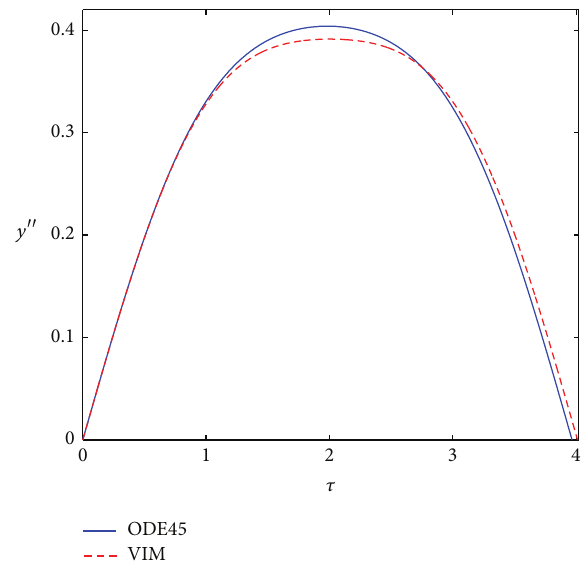
Figure 3: Comparison of the nondimensional acceleration 𝑦 󸀠󸀠 -time 𝜏 responseofthesystembytheVIMwiththeonebytheRunge-Kutta (ODE45) method when the suspension angle 𝜙 0 = 60 ∘